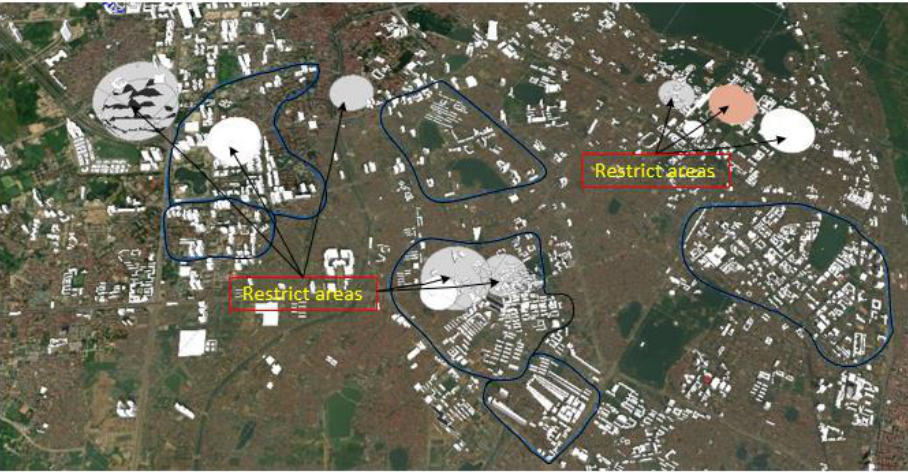
Figure 4. Geographical sector and restricted areas.